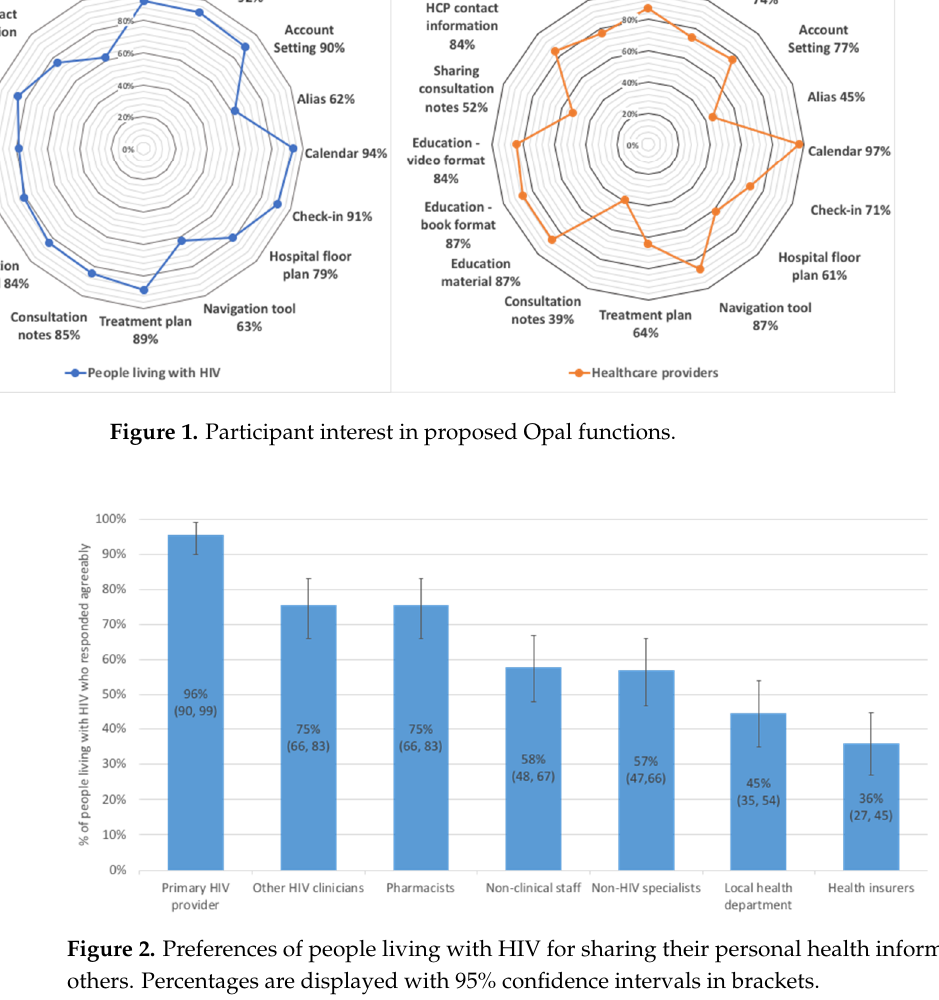
Figure 2. Preferences of people living with HIV for sharing their personal health information with others. Percentages are displayed with 95% confidence intervals in brackets.